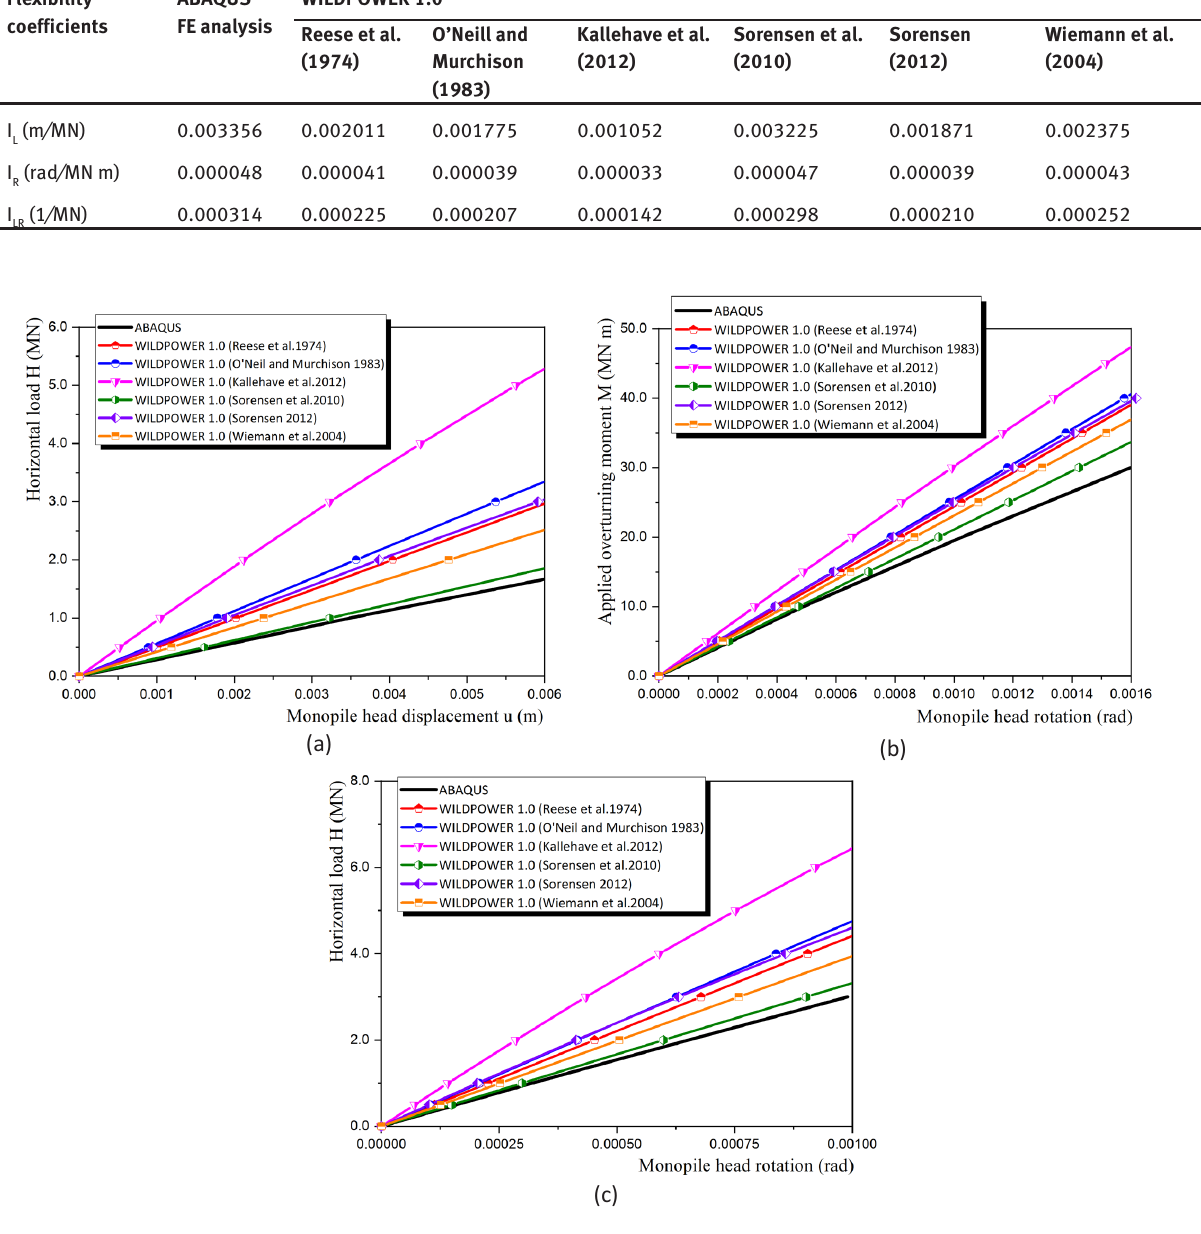
Figure 10: Monopile head movements in terms of monopile head applied loading: (a) H - u